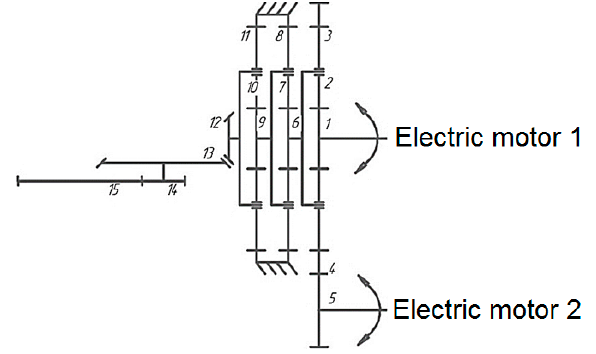
Figure 16. Kinematic diagram of the mechanical part of the actuator.